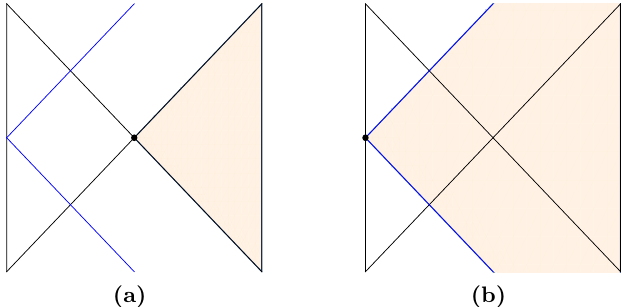
Figure 10. Measurement-induced entanglement wedge transition. The tan color denotes the entanglement wedge of the right side. (a) When a small subset of Majorana fermions is measured in the left side, i.e. m < m ∗ , the entanglement wedge of the right side is the right Rindler patch. (b) When a large subset of Majorana fermions is measured in the left side, i.e. m > m ∗ , the entanglement wedge of the right side includes part of the interior and of the left Rindler